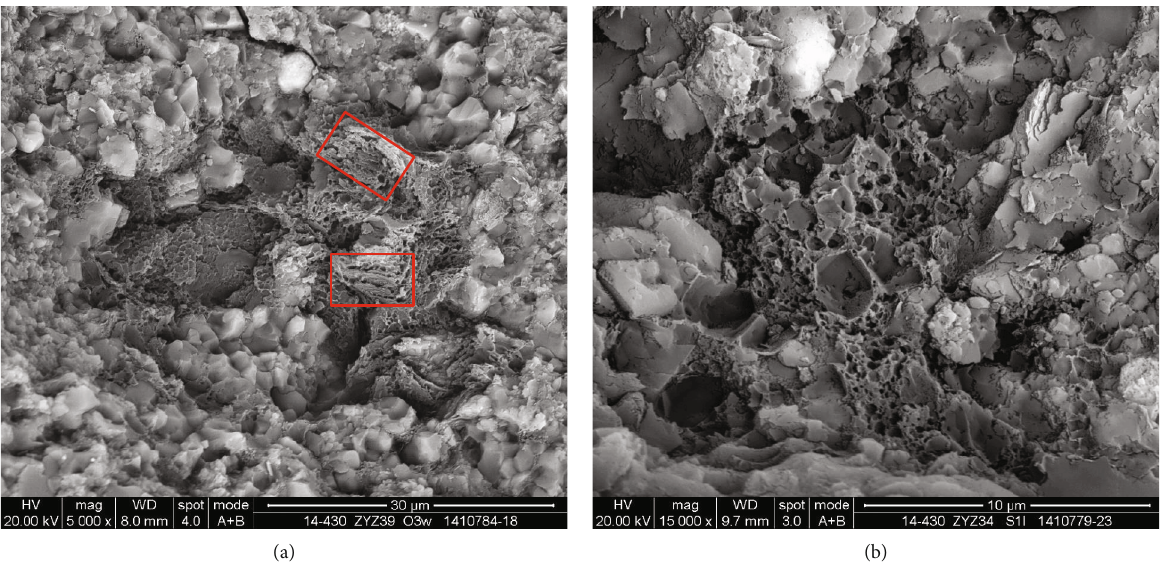
Figure 2: Multicellular algae in black shale. (a) The overview of the pro fi le; many multicellular algae can be observed. The aligned OM pores in the red panel probably indicate that the algae have inherent variation in their internal structure (well JY 2, 2570.89m (WF2 GZ), the TOC content is 3.66% and the R % is 2.65%). (b) unaligned OM pores (well JY 2, 2556.91m (LM4 GZ), the TOC content is 3.9% and the R o 2.46%).